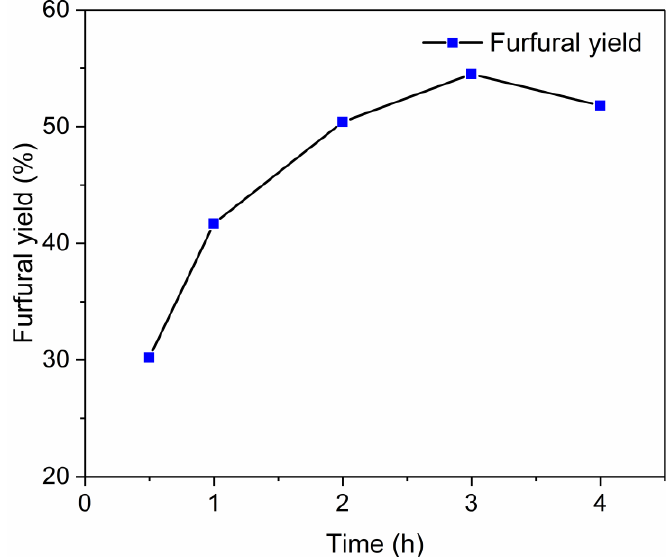
Figure 11. Time profile for the conversion of lignocellulosic biomass to furfural in the EMIMBr/SnCl 4 system. Reaction conditions: corn stalk 50 mg; 1000 mg of EMIMBr; 7 µ L water; 23 mg SnCl 4 ; 130 ◦ Table 4. Comparisons of catalytic performance of the EMIMBr/SnCl 4 system with representative catalytic systems for conversion of lignocellulosic biomass to furfural.